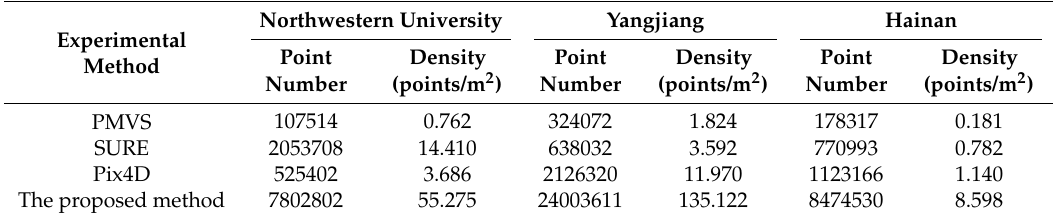
Table 5. Comparison of the point cloud